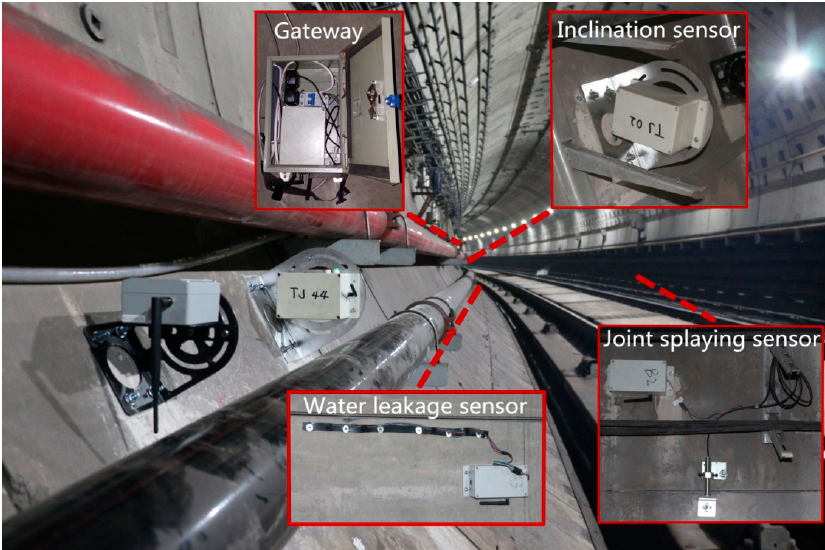
Figure 5. Tunnel monitoring system in Shanghai, China.